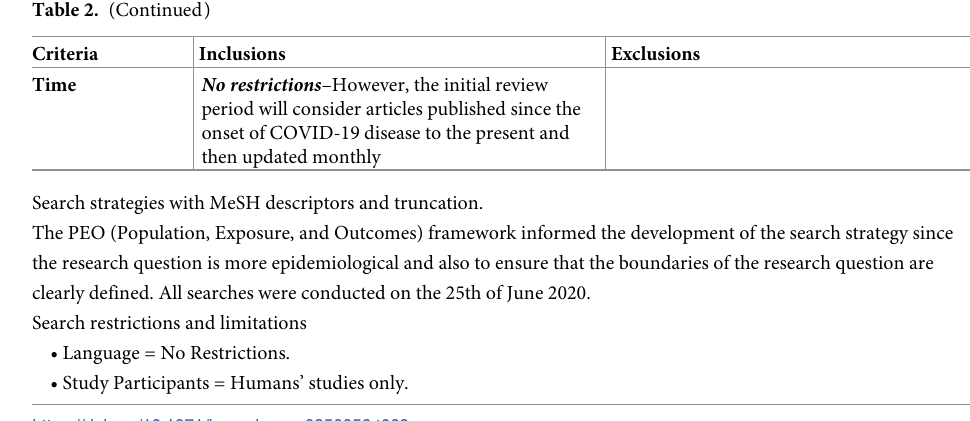
Table 3. Search strategy pilot search result from PubMed database and CKNI.